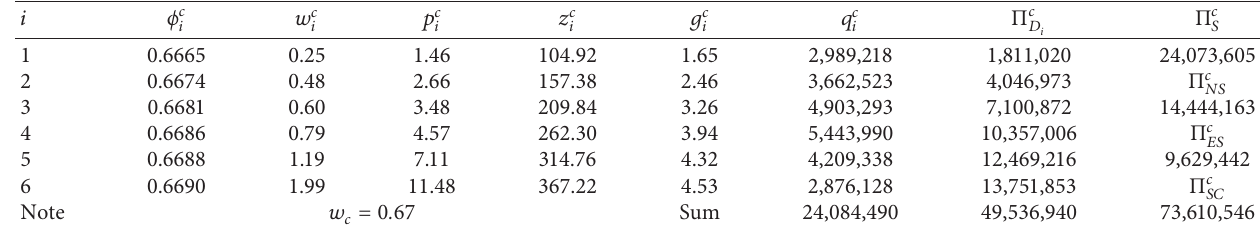
Table 7: Numerical analysis results of coordination decision scenario with WGD effort.